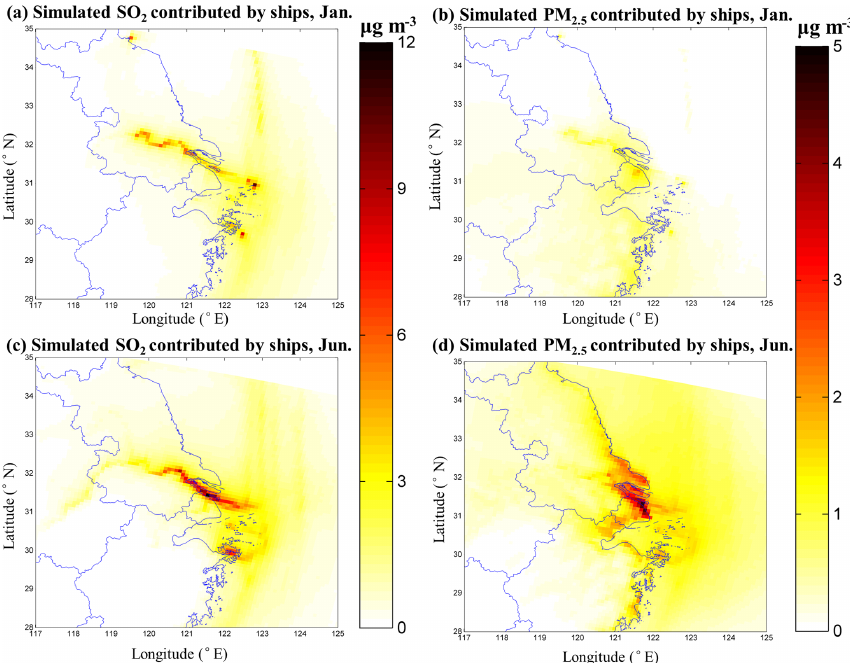
Figure 3. Simulated SO 2 (a, c) and PM 2 . 5 (b, d) concentrations contributed by shipping traffic sources in the YRD region, in January 2015 (a, b) and June 2015 (c, d)